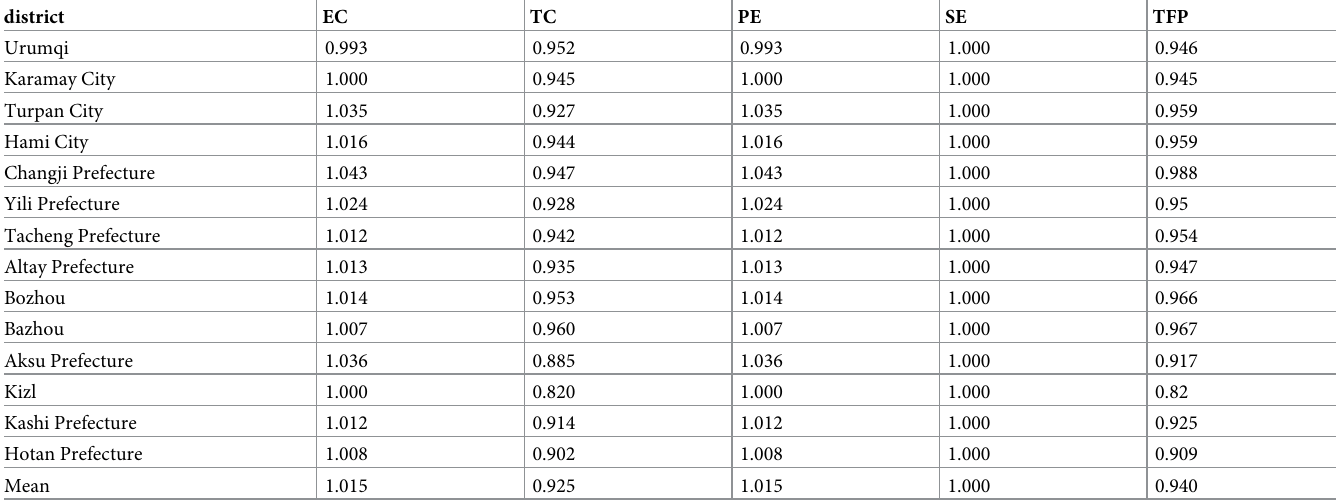
Table 5. The Malmquist index of eco- efficiency in 14 prefectures of Xinjiang. district